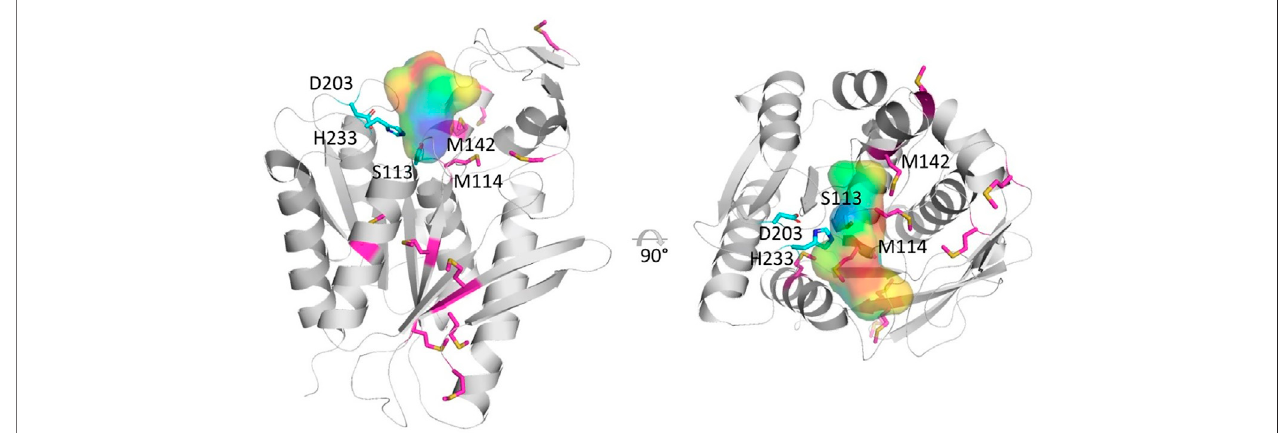
FIGURE 2 | Cartoon representation of the modelled structure of the lipase from Thermoanaerobacter thermohydrosulfuricus in two, 90 ° -separated orientations. Amino acids forming the catalytic triad (Ser-113, His-233 and Asp-203) are shown in a cyan stick representation, while methionine residues are shown in magenta. The active site cavity is represented as a semi-transparent surface colored according to hydrophobicity, ranging from blue (hydrophilic) to red (hydrophobic). The fi gure was generated using the program PyMOL